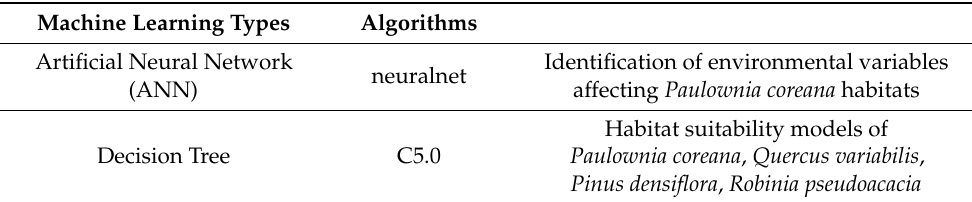
Table 2. Comparison of the machine learning